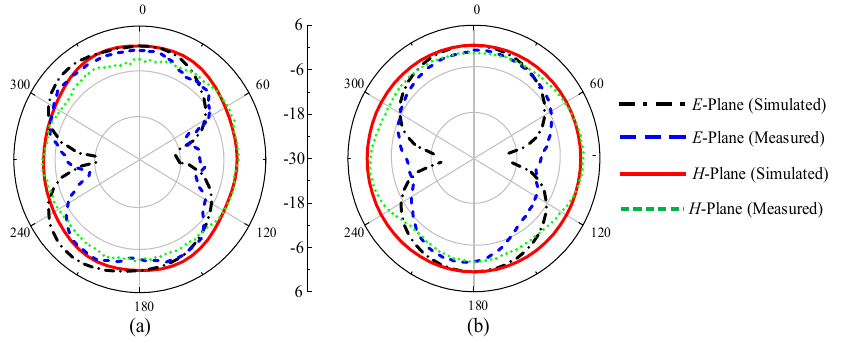
Figure 12. The proposed antenna’s radiation patterns for UWB mode: ( a ) 3.2 GHz and ( b ) 5.8 GHz.